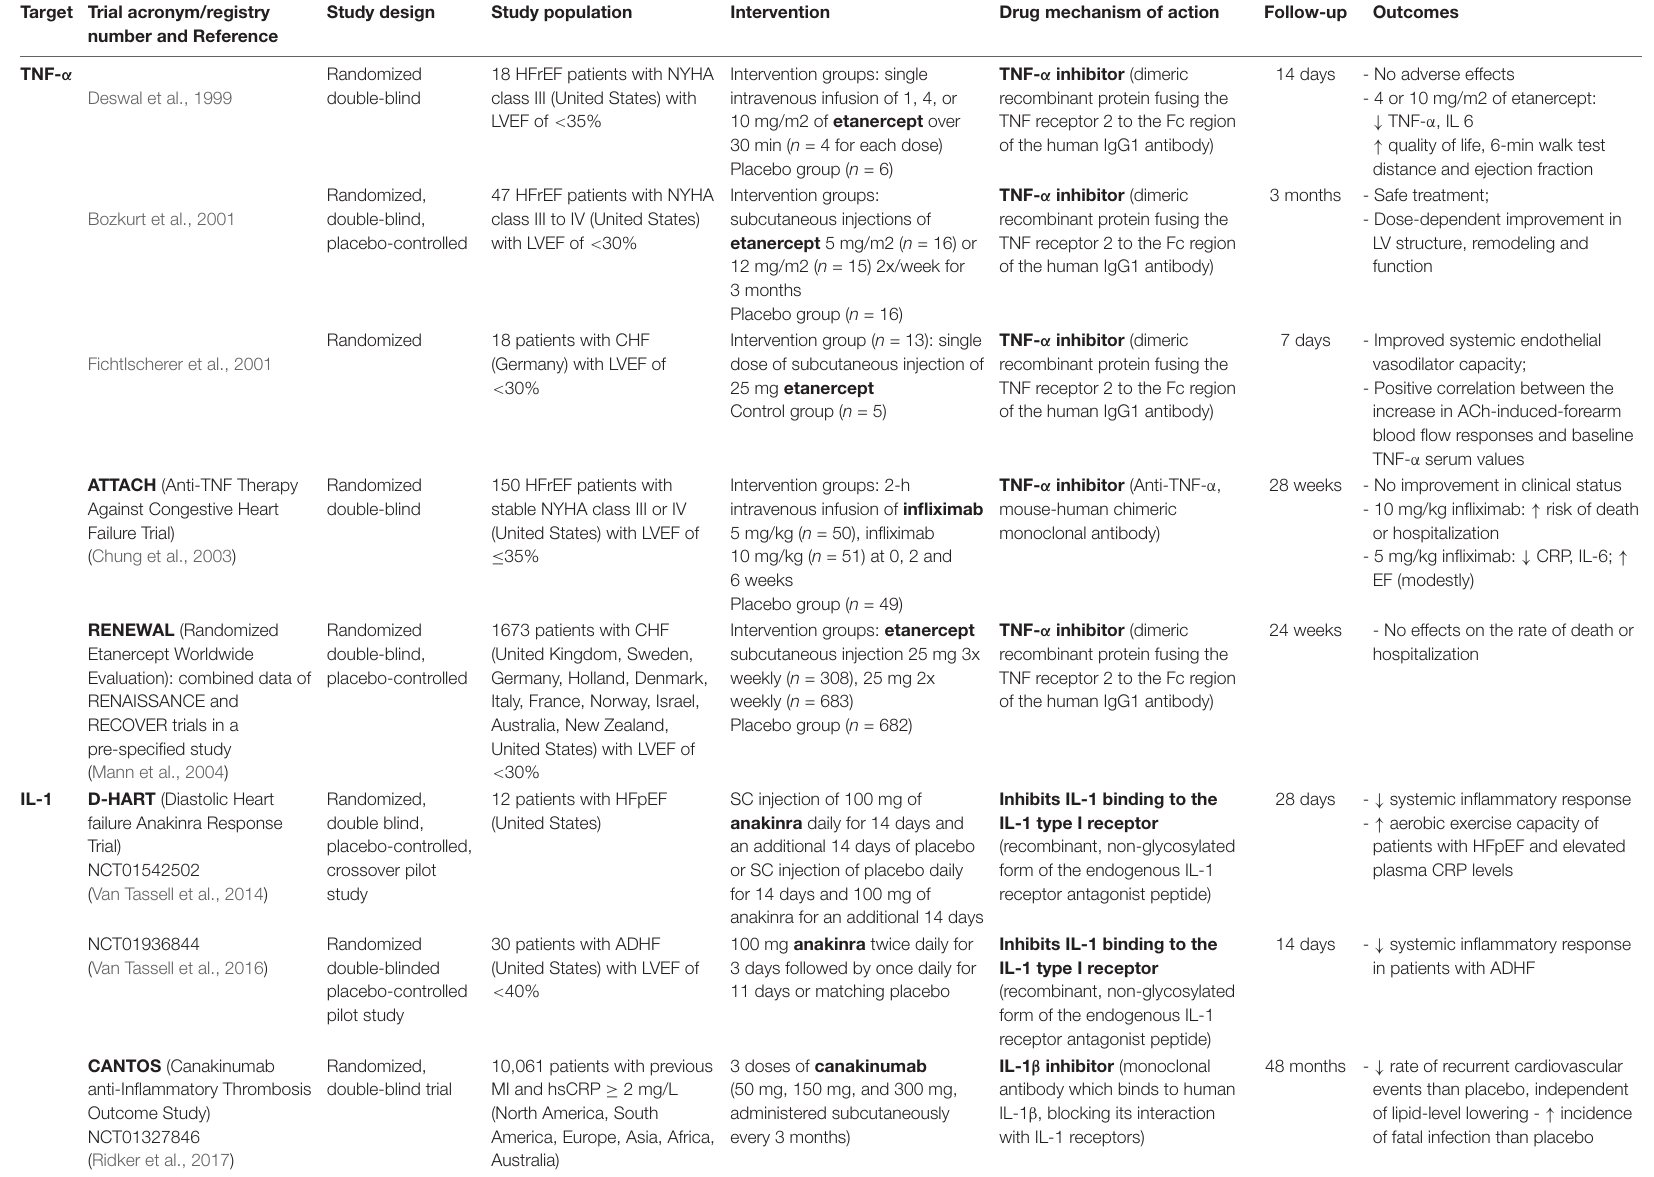
TABLE 1 | Trials targeting major inflammatory mediators of